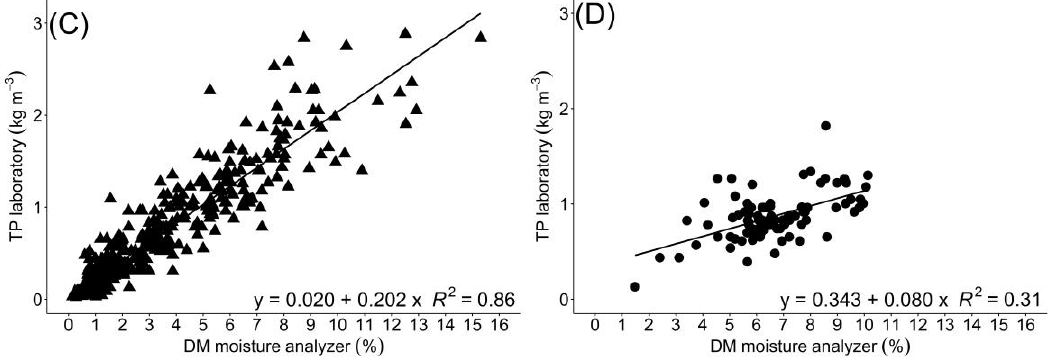
Figure 2. Relationships for the phosphorus concentrations measured in the laboratory versus dry matter measured with moisture analyser of the total sample set (n = 619): ( A ), cattle slurries ( ■ ) (n = 139); ( B ), pig slurries ( ▲ ) (n = 391); ( C ) and digestates (●) (n = 89); ( D ). The four regression models based on the potassium electrode readings are shown in Figure 3. The model of all LOMs had an R 2 of 0.94 and an RMSE of 0.302. The model of the pig slurries (C) had a lower R 2 of 0.91 than the overall model and an identical RMSE of 0.302. The digestates model had a lower R 2 (0.91) than the model for all LOMs and a larger RMSE (0.315), while the cattle slurries model had a higher R 2 of 0.93 and a lower RMSE calculated with 0.248.